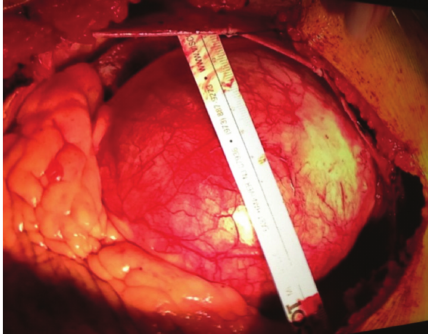
Figure 2: Gross image obtained during the Bentall procedure showing the giant ascending aortic aneurysm, 13cm in